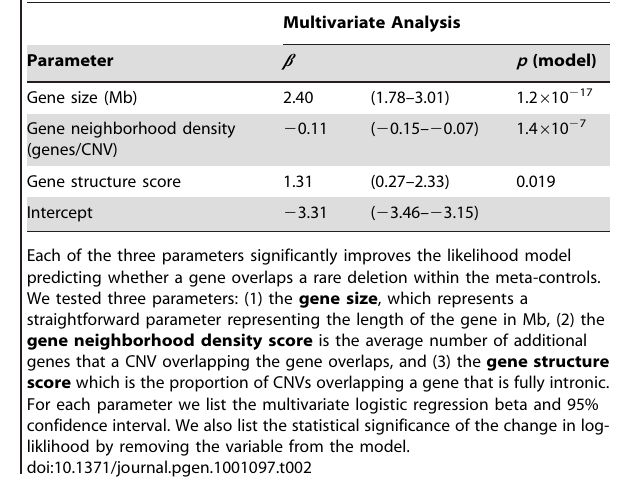
Table 1. Properties of observed deletions in the meta- controls versus randomly placed simulated deletions.